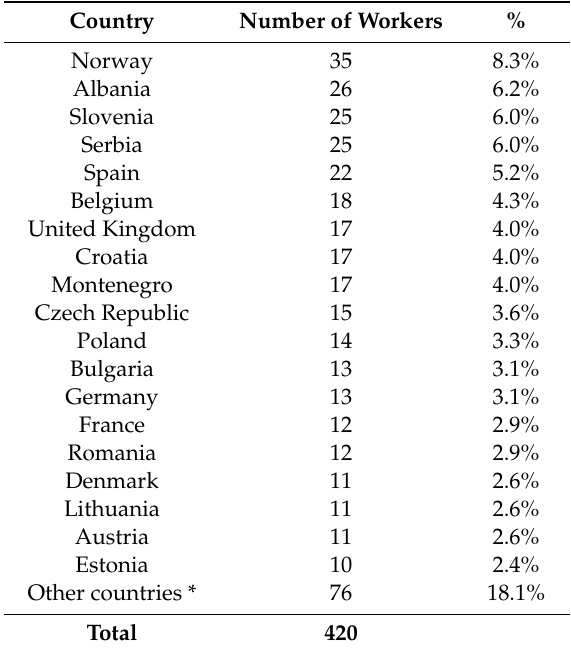
Figure 1. Age distribution of the workers. Table 1. Distribution of the sample of workers by country.